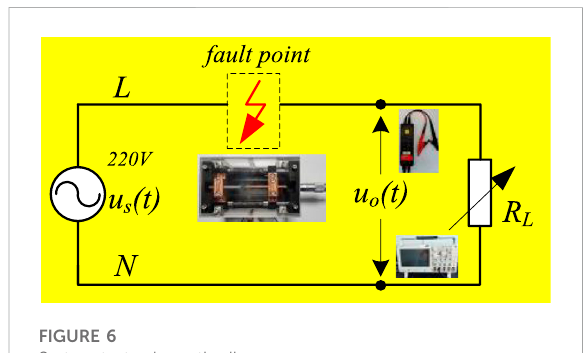
FIGURE 6 System test schematic diagram.